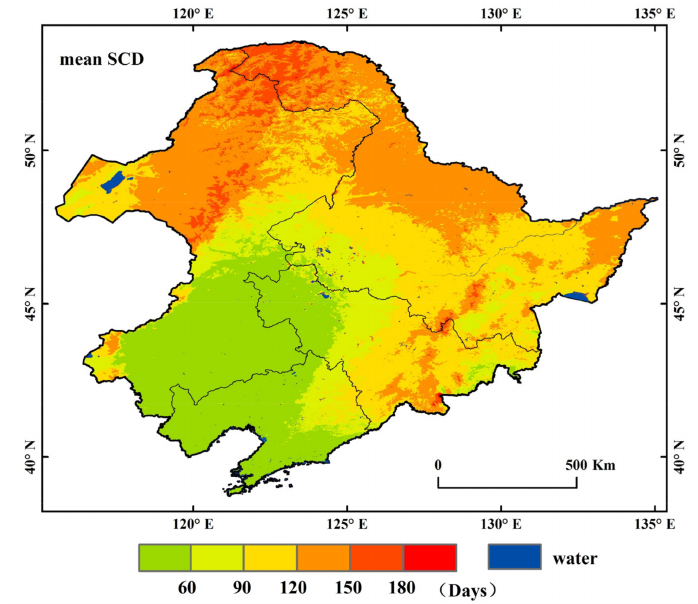
Figure 3. Spatial distribution of annual average SCD in Northeast China from HY2001 to HY2017. Figure 4 showed the histogram of annual average SCD computed for a 10-day interval from HY2001 to HY2017. The average SCD in Northeast China ranged from 0 to 230 d, with an obvious bimodal distribution, and the annual average SCD was 93 d. The frequency of SCD in the range from 10–20 d accounted for 9.95%, and that in the range from 120–130 d accounted for 13.92%.